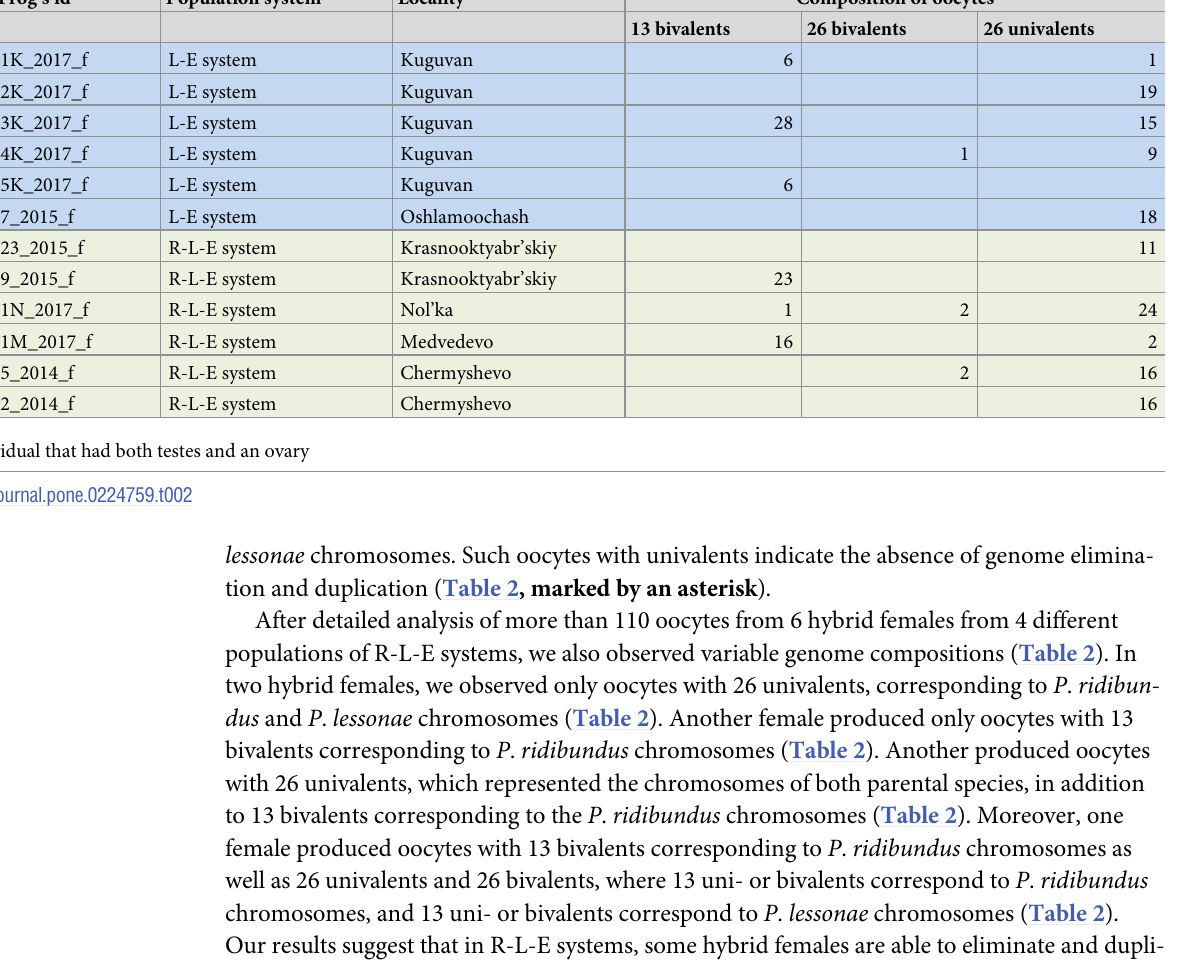
Table 2. Composition of diplotene oocytes from diploid hybrid frogs from L-E (marked blue) and R-L-E (marked green) systems.